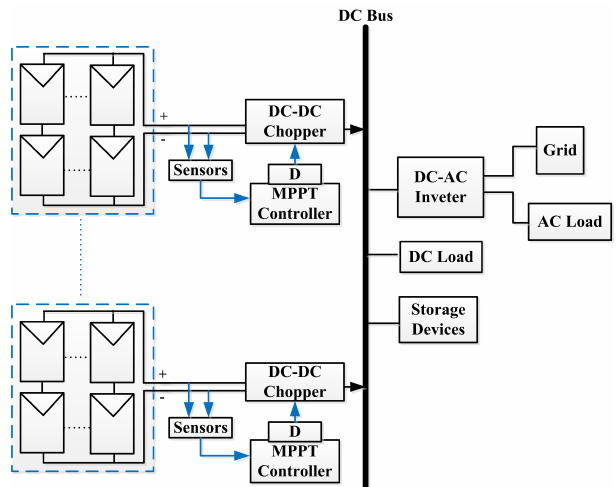
Figure 1. Distributed PV plant with MPPT mechanism.